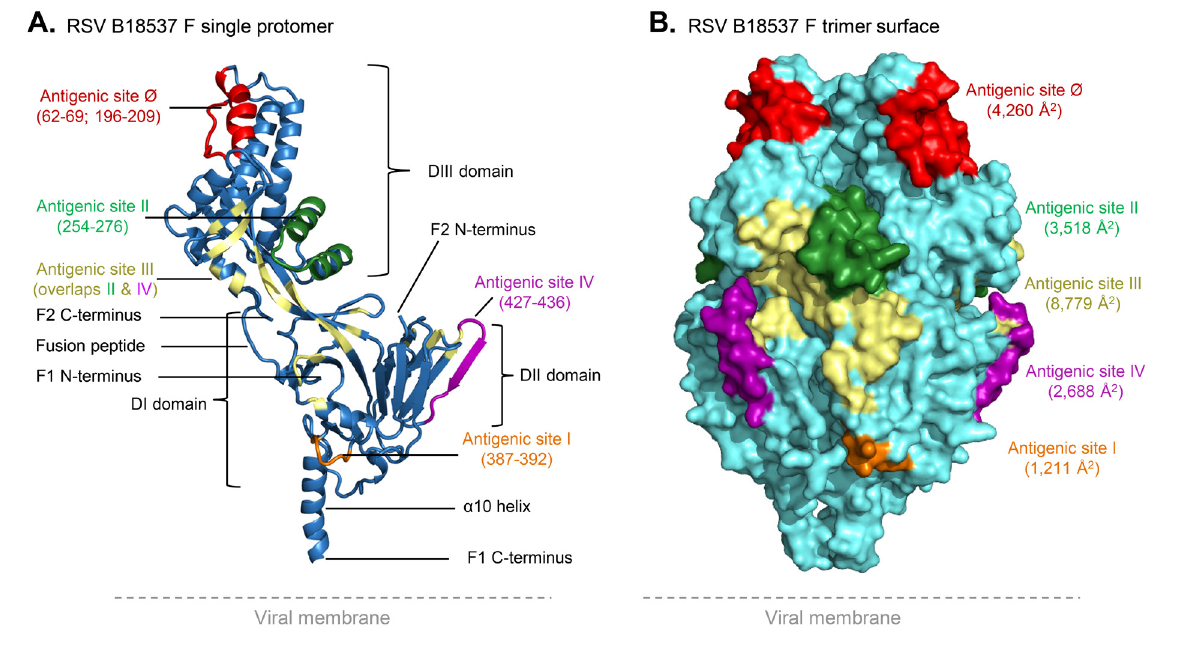
Figure 1. Crystal structure of the fusion glycoprotein of RSV B18537. (A) Ribbon representation of a single protomer of the RSV B18537 F glycoprotein. RSV F domains, antigenic sites, fusion peptide, and subunit termini are labeled. Antigenic site III is discontinuous and overlaps with sites II and IV. The resi- dues of site III overlapping with site II or IV are colored only as site II or IV, respectively. Another known antigenic site, site V [ 65 ], located between sites Ø and II and overlapped with sites Ø, II, and III, is not shown for clarity. (B) Surface representation of the RSV B18537 F trimer with the antigenic sites colored as in (A) and the antigenic surface area (Å 2 /protomer) indicated. The total trimeric accessible surface area (residues 18 to 509) is 52,225 Å 2 , calculated using a surface accessibility radius of 1.4